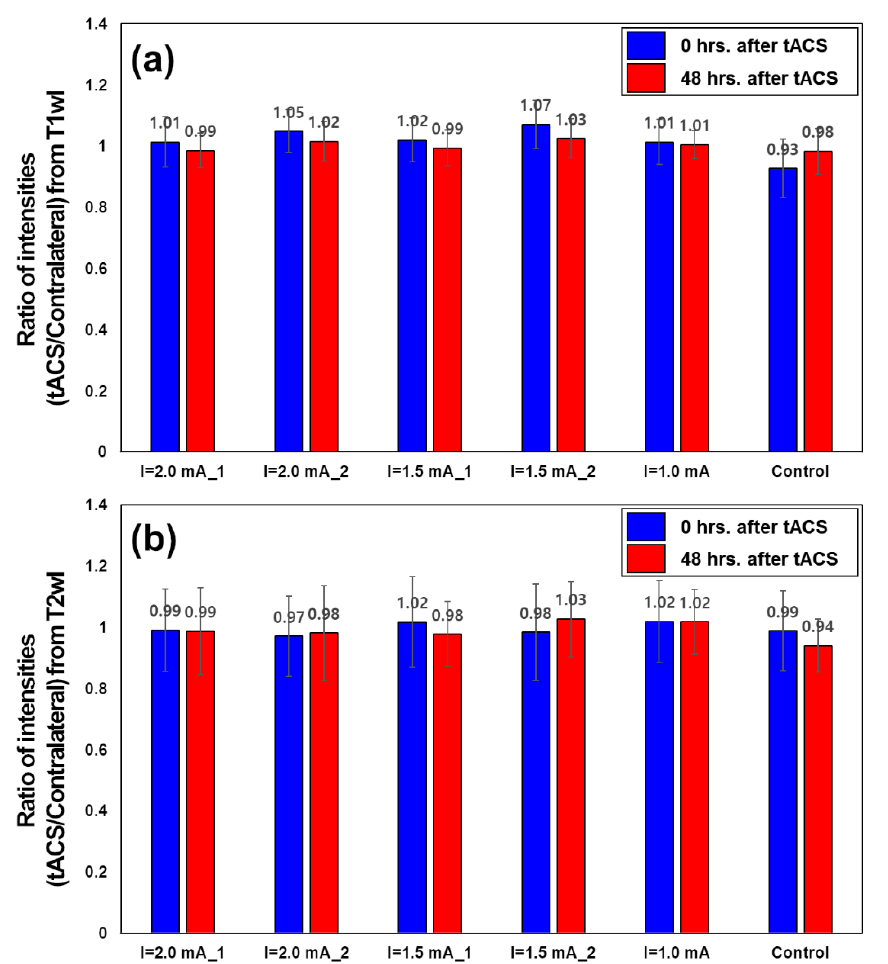
Figure 3. Ratios of the mean intensity values in tACS-applied and contralateral regions from ( a ) T1- and ( b ) T2-weighted magnetic resonance images. Although there was a slight difference in intensity between areas subjected to tACS and the opposite areas in both the T1- and T2-weighted magnetic resonance images, the difference was within a level of standard deviation.